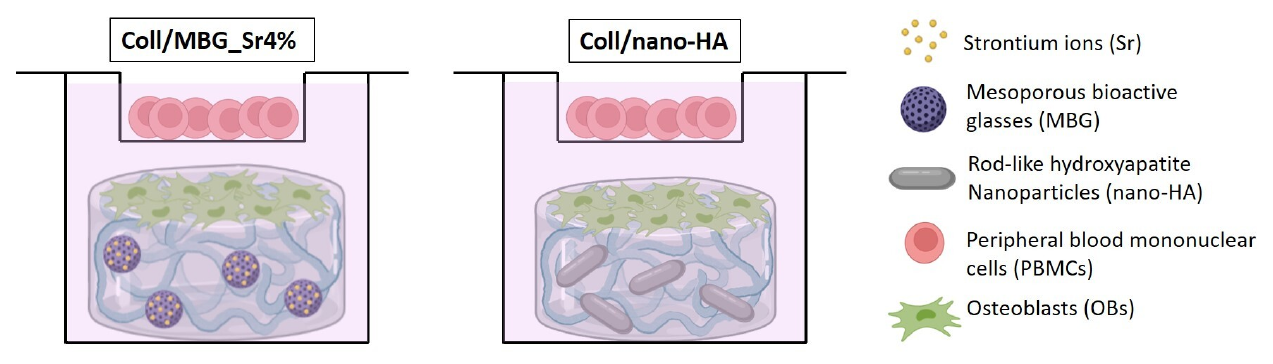
Figure 1. The set-up of the indirect co-culture within the materials. Osteoblasts (OBs) are seeded on the surface of the material and peripheral blood mononuclear cells (PBMCs) are co-cultured in the transwell device.